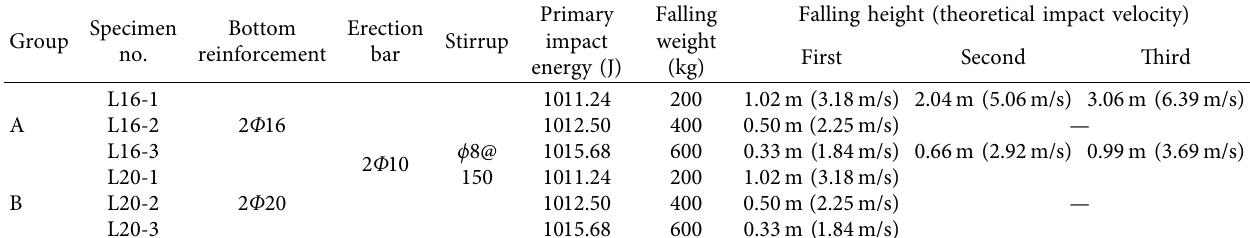
Table 1: Experimental test